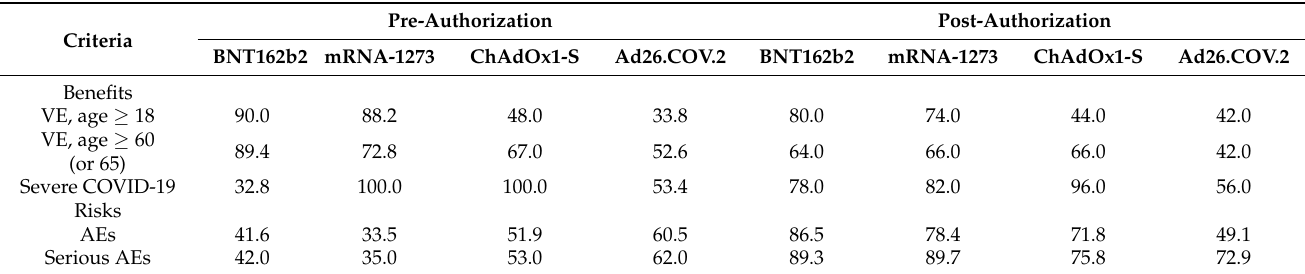
Table 2. Preference score of the benefit and risk criteria for each